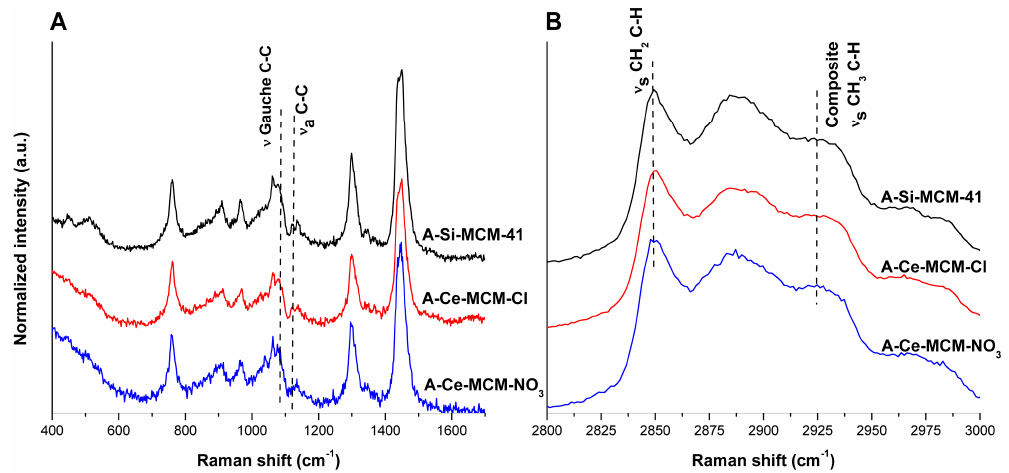
Figure 3. Raman spectra of the as-synthesized materials between 400 and 1700 cm − 1 ( A ) and 2800 and 3000 cm − 1 ( B ). The signals used for the determination of the disorder parameters are indicated.